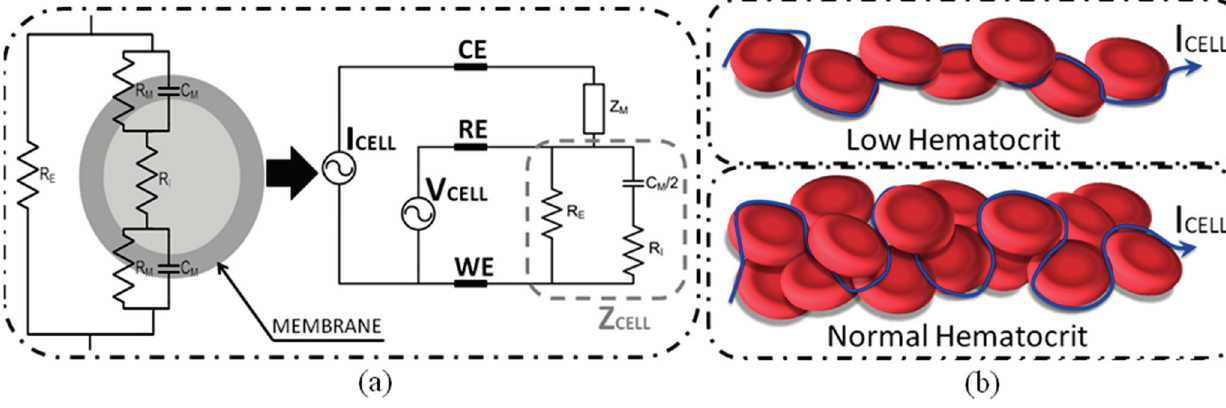
Figure 1. ( a ) Red Blood Cell (RBC) electrical model. Three electrodes topology for RBC sample; ( b ) Current flow path through different blood samples with different hematocrit. (Reproduced from [27] with kind permission from IEEE